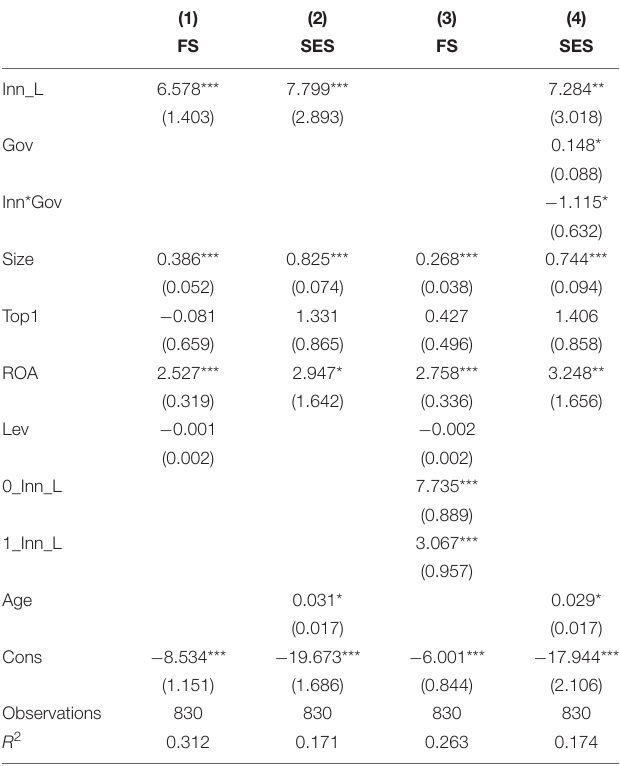
TABLE 5 | Regression results.